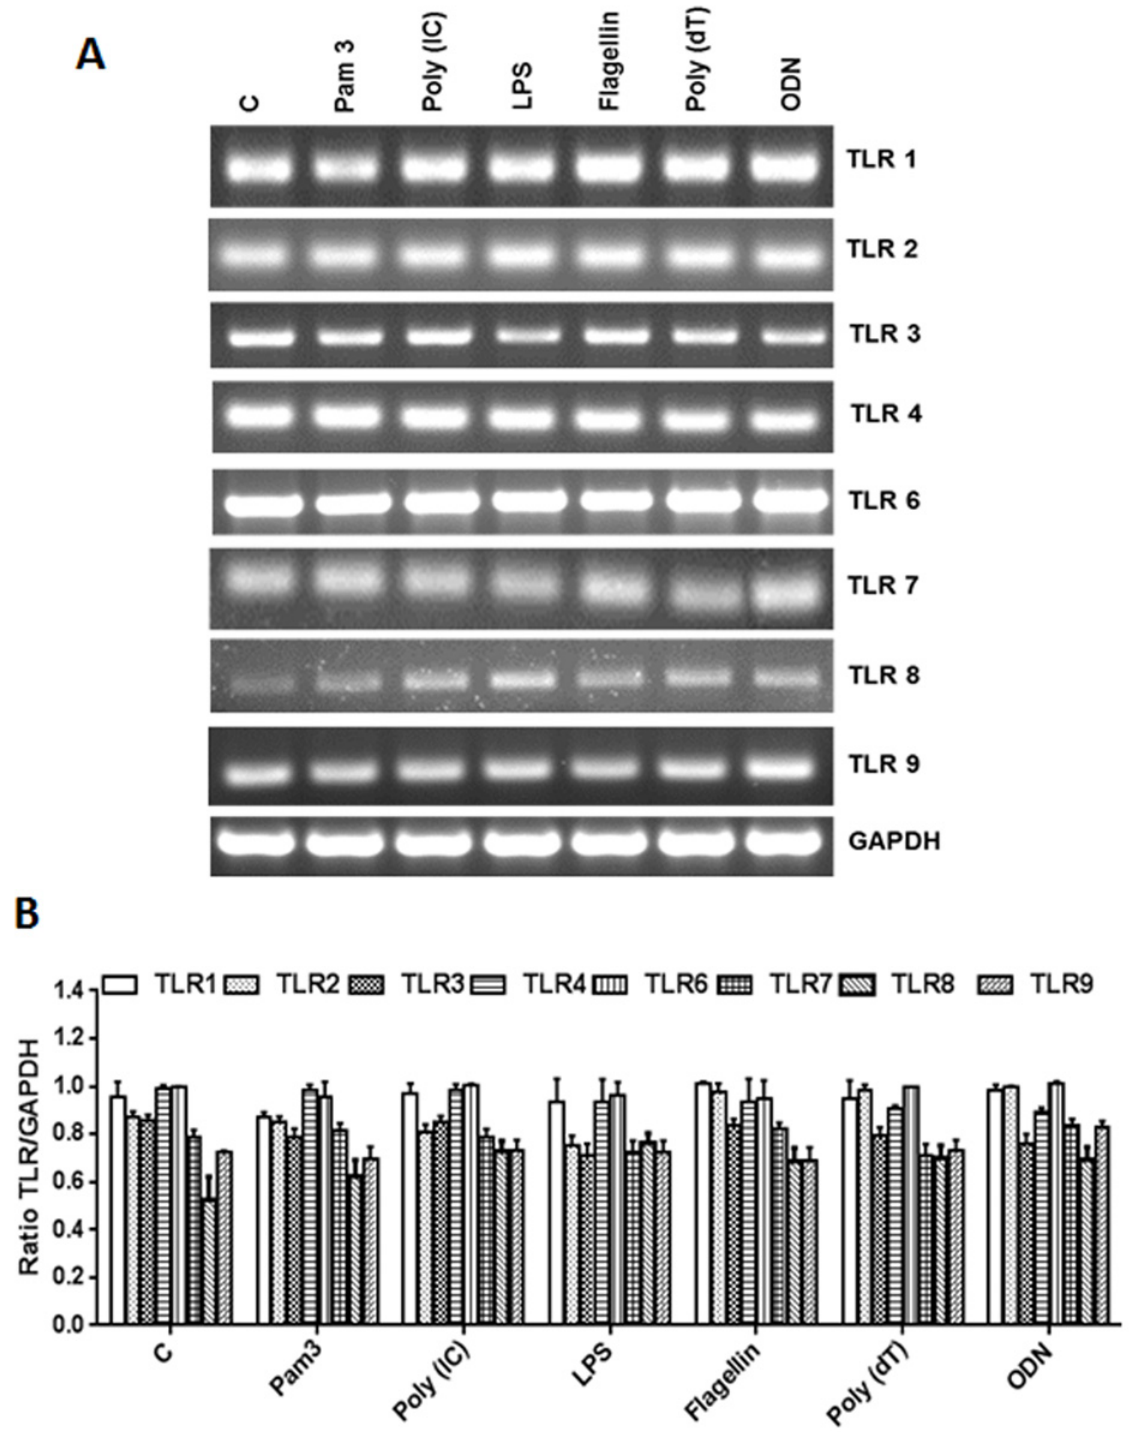
Fig 1. RT-PCR analysis of TLR expression in 661W cells. 661W cells were either left untreated (control) or challenged with the indicated TLR ligands: Pam3CSK4 (10 μ g/ml), Poly(IC) (10 μ M), LPS (10 μ g/ml), Flagellin (250 ng/ml), Poly(dT) (10 μ M), or ODN (10 μ g/ml) for 8h. Total RNA was extracted, reverse transcribed, and subjected to semi-quantitative RT-PCR using primers for specific TLRs, with glyceraldehyde 3-phosphate dehydrogenase (GAPDH) as the control (A). Band intensity was quantified by densitometric analysis using Image J analysis software (NIH) and presented as the relative band intensity of TLRs vs. GAPDH (B). Data points and error bars represent mean ± SD from two independent experiments.